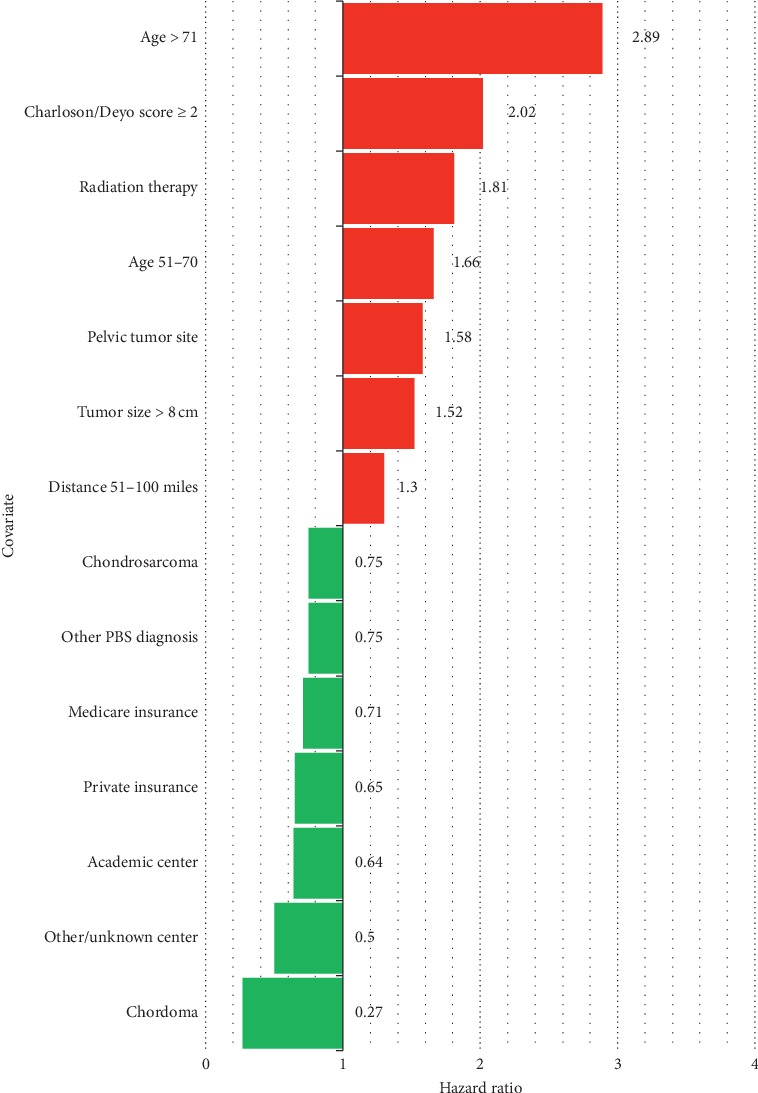
Comparison of relative association between covariates and survival. Only covariates with statistically significant higher (red) or lower (green) HR are shown.